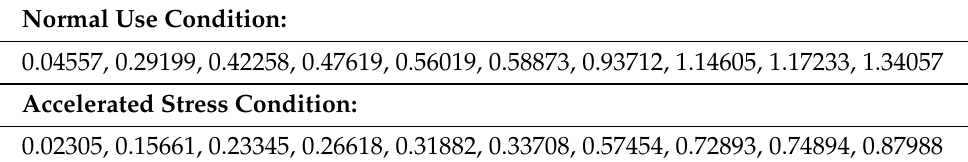
Table 1. Simulated CSPALT data with complete information from which the Type-II censored data were